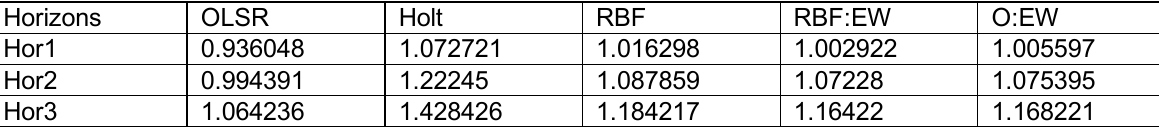
Table 4 : The RAE Values of the Forecasts of Table